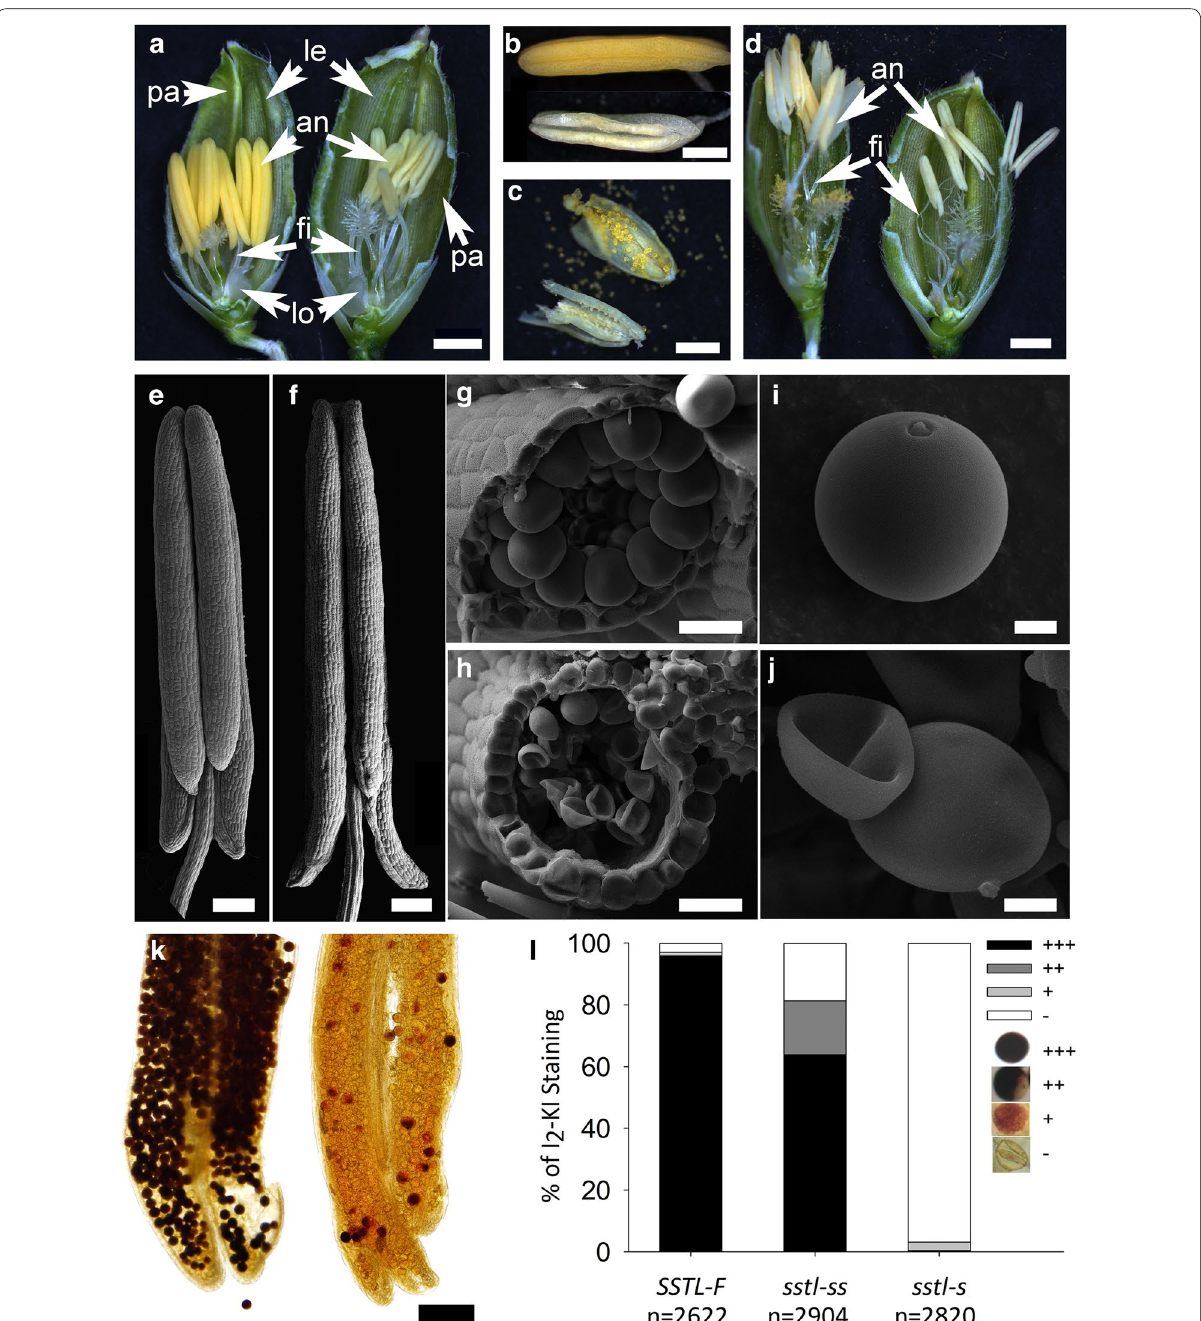
Fig. 2 Floral morphology of fertile and sterile plants from sstl offspring. a The floral structure between SSTL ‑ F (left) and sstl ‑ s (right) at heading stage. Bar 1 mm. b The exterior of anther in SSTL ‑ F (above) and sstl ‑ s (below). Bar 0.4 mm. c Mature pollen was presented after chopping the = = anthers of SSTL ‑ F (above) and sstl ‑ s (below). Bar 0.4 mm. d Filament elongation of SSTL ‑ F (left) and sstl ‑ s (right) during anthesis. Bar = i SEM observation of SSTL ‑ F and f , h , j sstl ‑ s in anther and pollen. e , f Bar 0.2 mm; g – j bar 50 μm. k I 2 KI staining of SSTL ‑ F (left) and sstl ‑ s (right). = = Bar 200 μm. l Pollen viability in different maturity types of SSTL ‑ F , sstl ‑ ss, and sstl ‑ s . an anther, fi filament, le lemma, lo lodicule, pa =